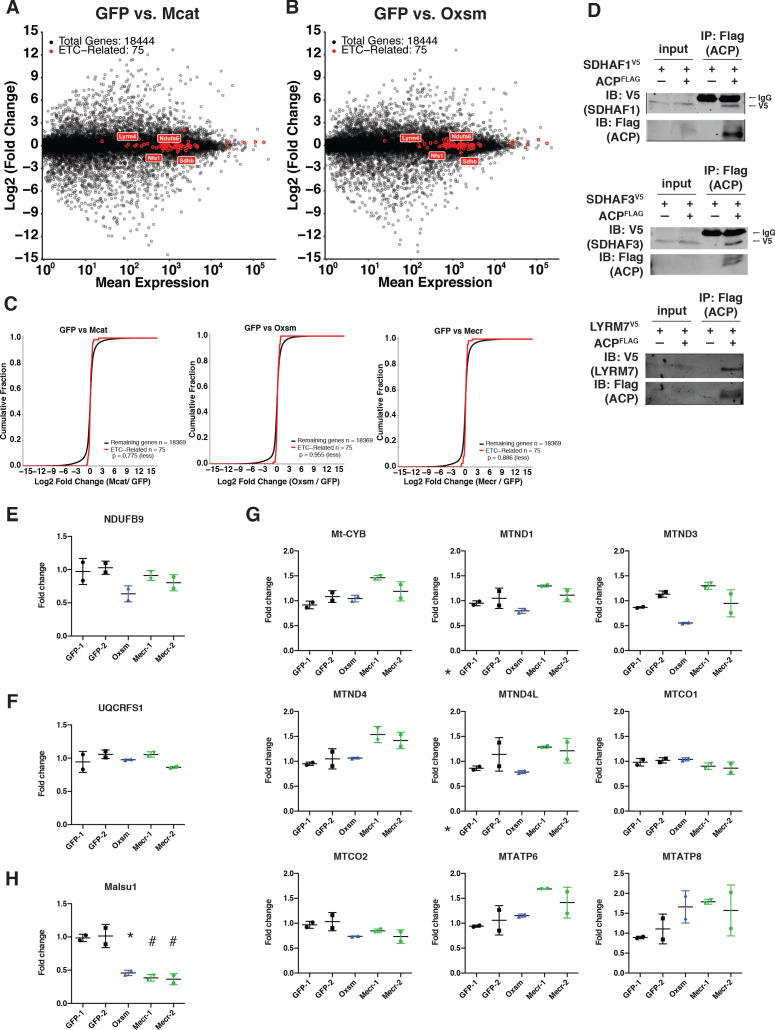
Transcription of ETC subunit encoding genes and translation of mitochondrially encoded proteins are unaffected in mtFAS mutants.(A-C) Quadruplicate samples from mtFAS mutant cells and controls were grown under proliferative conditions. Total RNA was isolated, used as input for mRNA library prep, and sequenced. Resulting data were aligned to the mouse genome and analyzed for differential expression. ETC subunit encoding transcripts are shown in red vs. all other transcripts (black). (C) Cumulative distribution plots showing no difference in abundance between ETC encoding transcripts vs. all other genes for the indicated mtFAS mutant vs. GFP control, p>0.05, Wilcoxon rank-sum test. (D) HEK293T cells were transiently transfected with human NDUFAB1-Flag or empty vector control along with the indicated LYRM-V5 constructs, grown for 48 hr after transfection, harvested, and crude mitochondrial lysates were prepared by differential centrifugation. Flag immunoprecipitation was performed and eluates were blotted with the indicated antibodies alongside 10% of input. (E-H) Duplicate samples from the indicated cell lines were grown under proliferative conditions and subjected to TMT labeling and quantitative proteomics analysis. Relative abundance of the indicated LYR protein (E), LYR target (F), mitochondrially encoded proteins (G), and MALSU1 (H). *=p < 0.05, #=p < 0.01, error bars are SD. All statistical comparisons shown are between mtFAS mutants and GFP-1 clone.